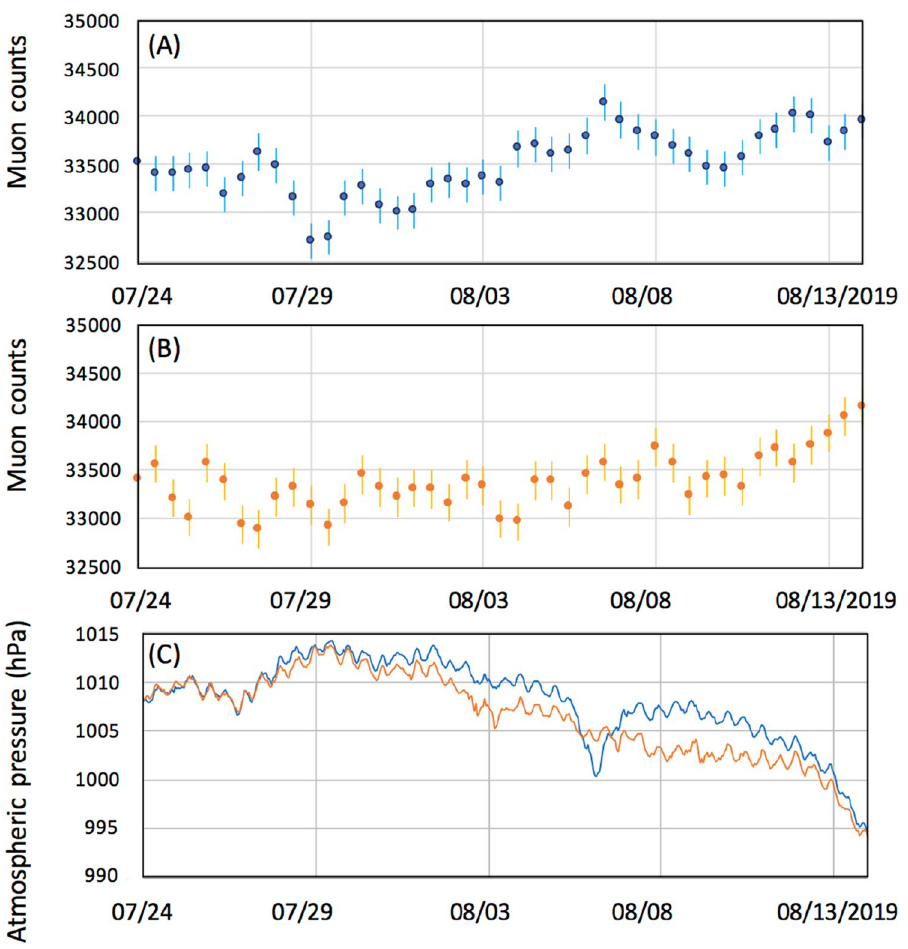
Figure 13. Time-sequential muon count rate observed in the eastern azimuthal angle region (0 < tan ϕ < 1.0) ( A ) and the western azimuthal angle region (− 1.0 < tan ϕ < 0) ( B ). The vertical bars associated with the data points indicate 1σ error bars. The time-dependent BP variations observed at Yakushima (blue) and Naze (orange) are also shown ( C